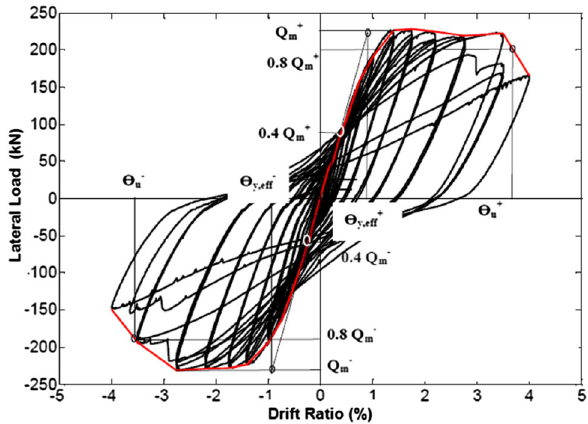
Fig. 20 Quantification of strength and ductility of test specimens.